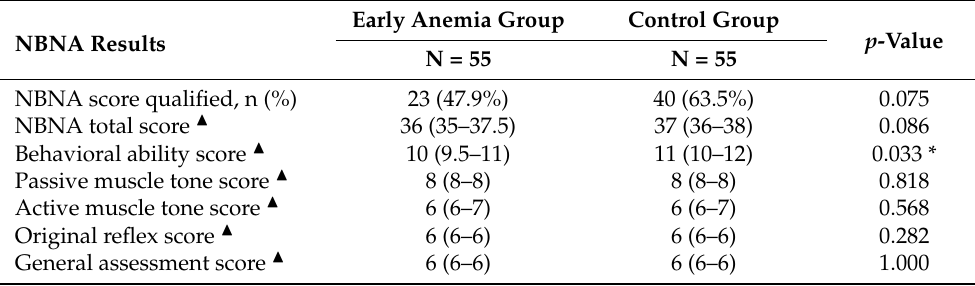
Table 2. Comparison of NBNA results between the early anemia group and control group (N = 110).